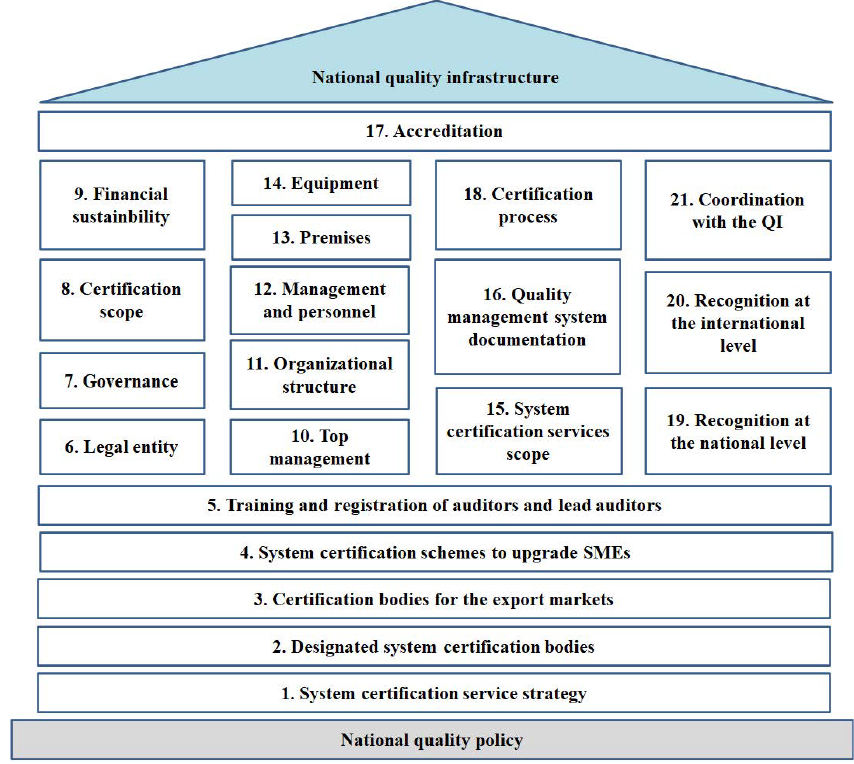
Figure 2: Overview of pillars and building blocks of system certification for national quality infrastructure